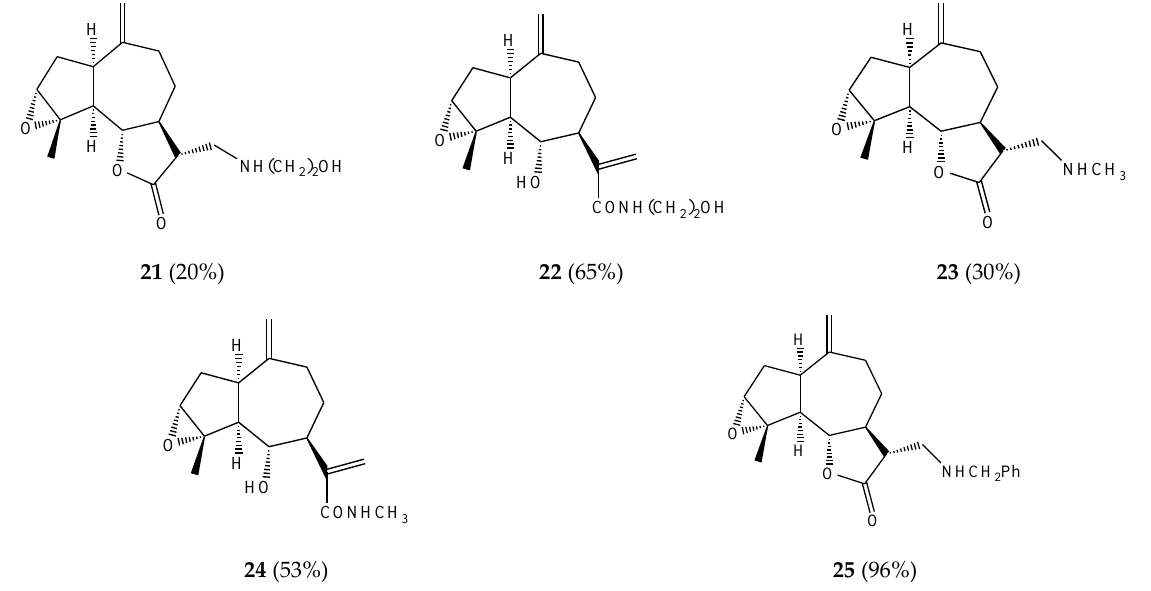
Figure 4. Structures of amino derivatives of estafiatin 21 – 25. Monoethanolamine derivative 21 is also a crystalline substance of the composition C 17 H 25 O 4 N with a melting point of 135 – 137° (from ethyl alcohol). The IR spectrum of 21 contained absorption bands of C – N (1130 cm −1 ) and hydroxyl (3530 cm −1 ) groups, as well as absorption bands of the carbonyl group of lactone (1780 cm −1 ). The 1 Н NMR spectrum showed a characteristic signal for protons at C-3 in the form of a broadened singlet at 3.75 ppm, and a signal for the methyl group at C-4 in the form of a singlet at 1.50 ppm was observed. Moreover, the proton H-6 of the lactone was present as a triplet at 3.95 ppm (J = 10 Hz), and the protons of the exomethylene group at H-14 in the form of two broadened singlets at 4.75 and 4.82 ppm; the protons of the H-13 signals were observed as a multi- plet at 2.67 ppm, shifted into a strong field. Monoethanolamide derivative 22 is a crystalline substance of the composition C 17 H 25 O 4 N with a melting point of 156 – 158° (from ethyl alcohol). According to the data of the IR spectrum, it was established that molecule 22 contained a hydroxyl group (3530 cm −1 ), and a carbonyl amide group (1660 cm −1 ). In the 1 H NMR spectrum there was a signal characteristic of protons at C-3 in the form of a broadened singlet of 3.28 ppm, a signal of the C-4 methyl group in the form of a singlet at 1.56 ppm, a signal of heme hy- droxyl proton at C-6 as a triplet at 4.0 ppm (J = 10 Hz), a signal of the NH proton in the form of a broadened singlet at 2.14 ppm, and signals of the protons of the exomethylene group in the form of two doublets, at 5.4 and 6.1 ppm (J = 2.5Hz). Methylamine derivative 23 has the composition C 16 H 23 O 3 N, is a crystalline substance with m.p. 138 – 140 °C (ethyl acetate-hexane), and R f 0.48 (ethyl acetate:benzene, 3:2). The IR spectrum of 23 showed absorption bands of lactone carbonyl (1780 cm −1 ) and C – N (1180 cm −1 ). In the 1 H NMR spectrum the signal of the H-3 proton was observed, namely a broadened singlet at 2.9 ppm, and the signals of methyl protons at C-4 in the form of a singlet at 1.56 ppm. Due to the polarity of the amino group, the signal of the lactone proton H-6 in the form of a triplet with SSCC of 10 Hz was shifted into a strong field and was observed at 3.18 ppm. Two broadened singlets, at 4.56 and 4.64 ppm, were assigned to exomethylene protons C-14, and the signals of protons at C-13 were observed as a multiplet at 2.50 ppm. In addition, signals of protons of the amino group were present in the form of a broadened singlet at 2.70 ppm and a singlet at 1.90 ppm.